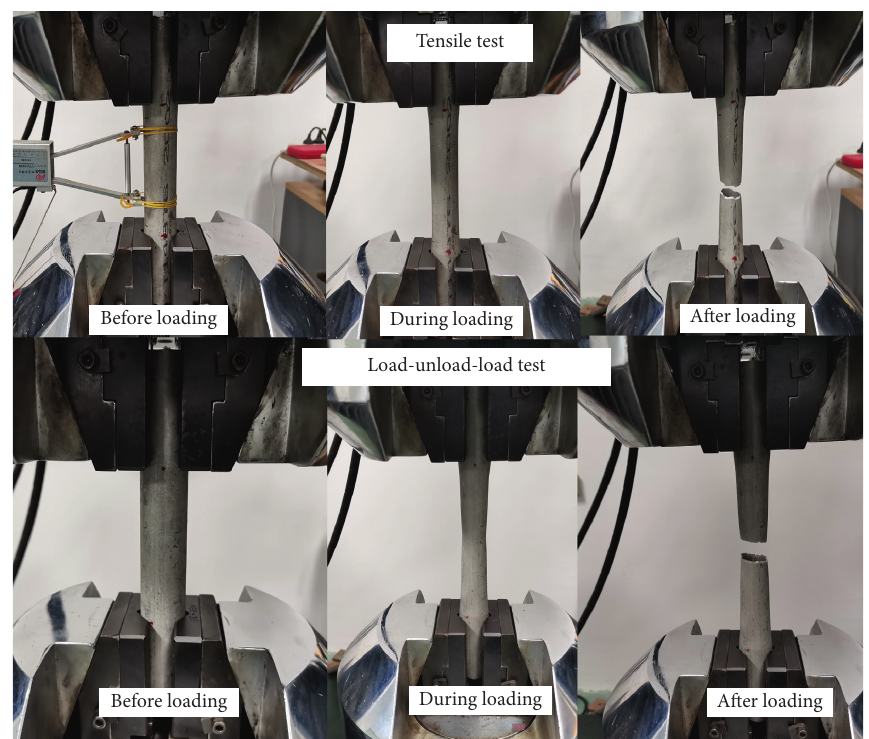
Figure 3: “Tensile” and “load-unload-load” tests.